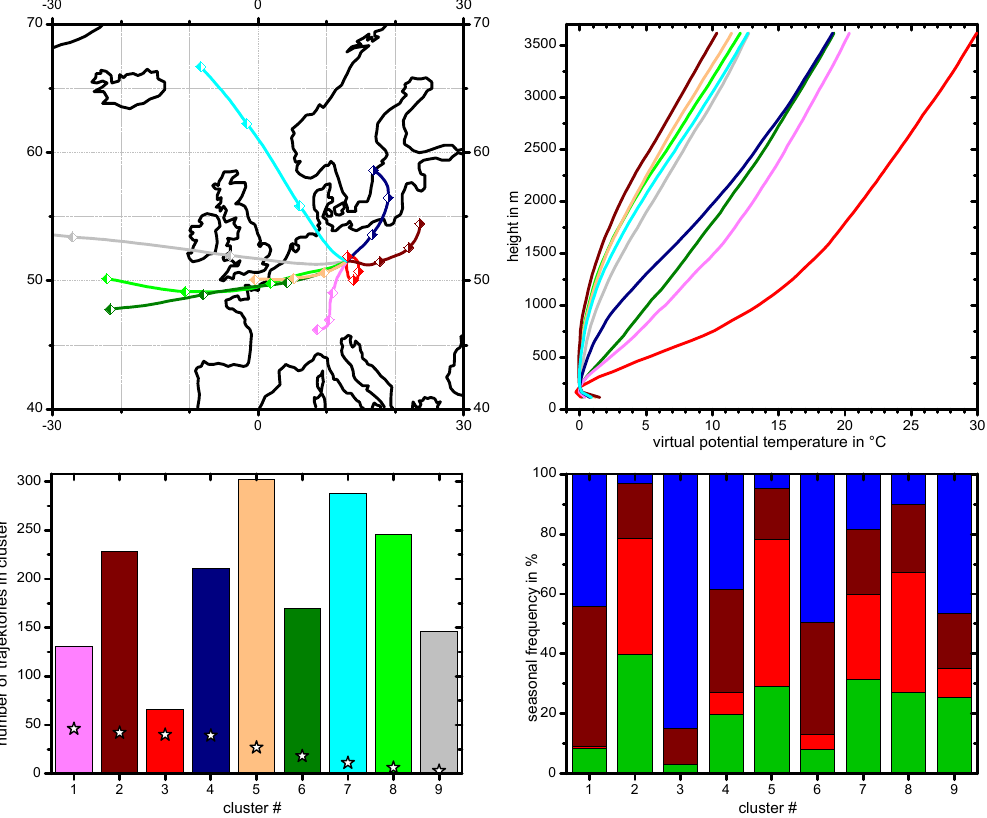
Fig. 8. Results of the back trajectory cluster analysis, 2005-2009: (a) mean back trajectories, (b) mean pseudo-potential temperature profiles, (c) frequency of the clusters in days (bars) including the number of limit value exceedances (star), (d) seasonal occurrence of each cluster (green: spring, red: summer, brown: fall, blue: